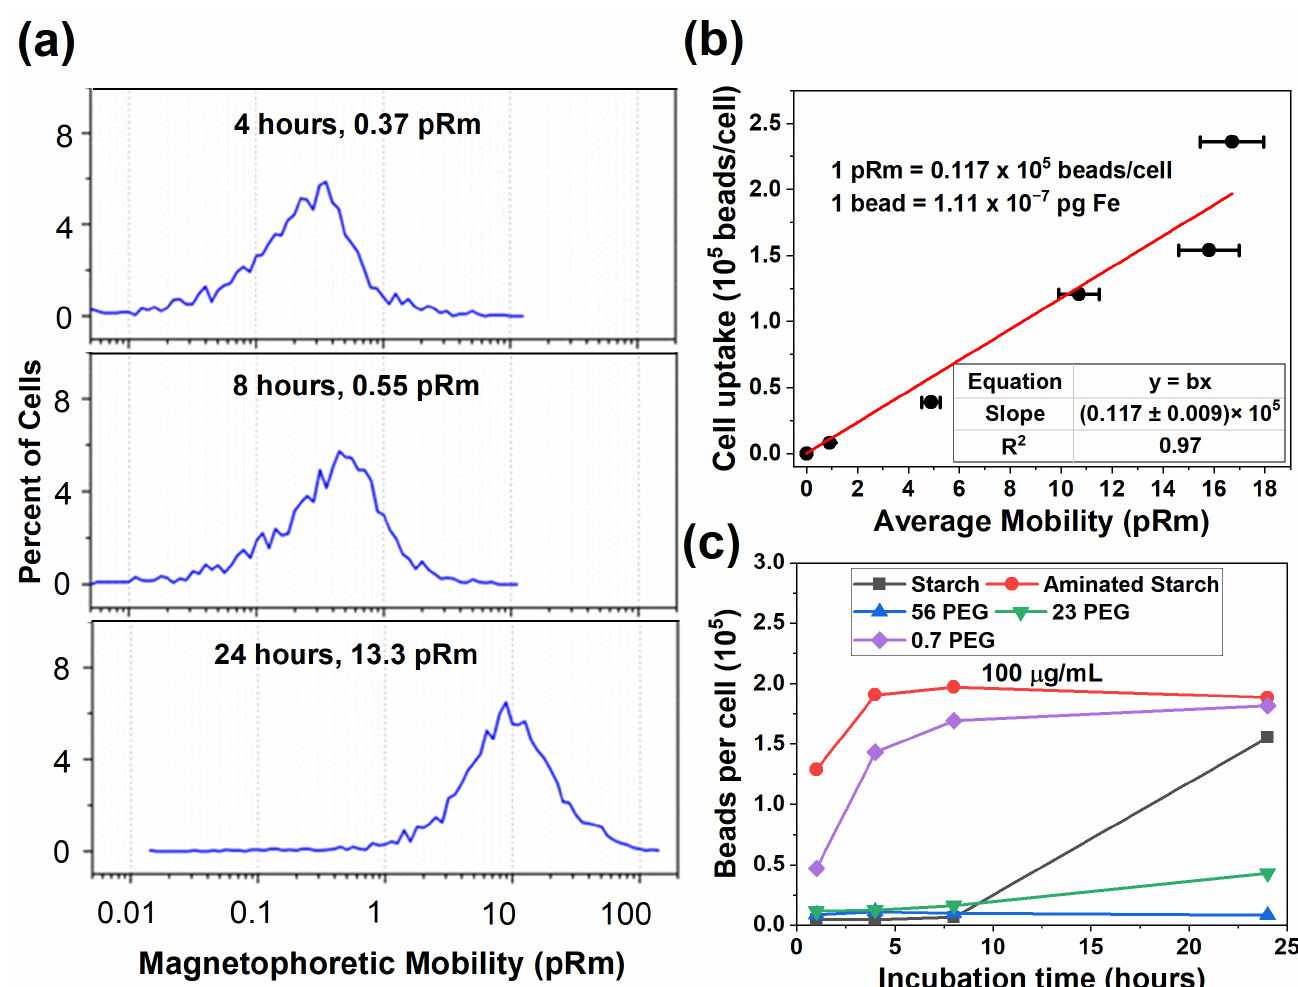
Figure 2. Magnetophoretic mobility and bead uptake. ( a ) Example of mobility histograms versus time of exposure of CHO-K1 cells in monolayer culture to 124 nm starch-coated MNPs at 37 °C in CM. ( b ) Calibration graph based on mobility versus beads per cell [9,19,38]. Each one pRm mobility increase corresponds to 0.117 × 10 5 beads per cell. ( c ) Beads per cell versus time of incubation with 100 μg Fe/mL of the beads described in Figure 1 c and Table 1.